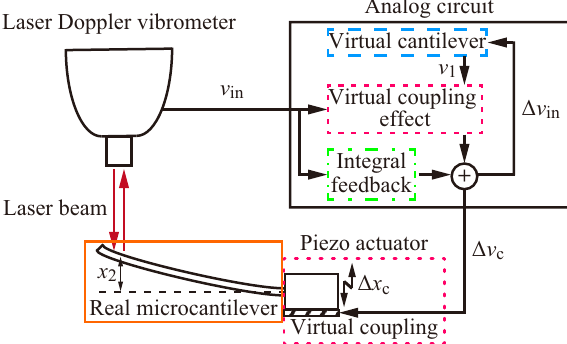
Figure 2. Schematic diagram of the experimental setup. The laser Doppler vibrometer measures the real microcantilever’s velocity. The output signal of the laser Doppler vibrometer v in drives the analog circuit. The analog circuit calculates the displacement of the virtual cantilever v 1 , the virtual coupling effect and the integral feedback for self-excited oscillation. The piezo actuator actuates the real microcantilever according to the output voltage of the circuit ∆ v c to realize the virtual coupling and the self-excited